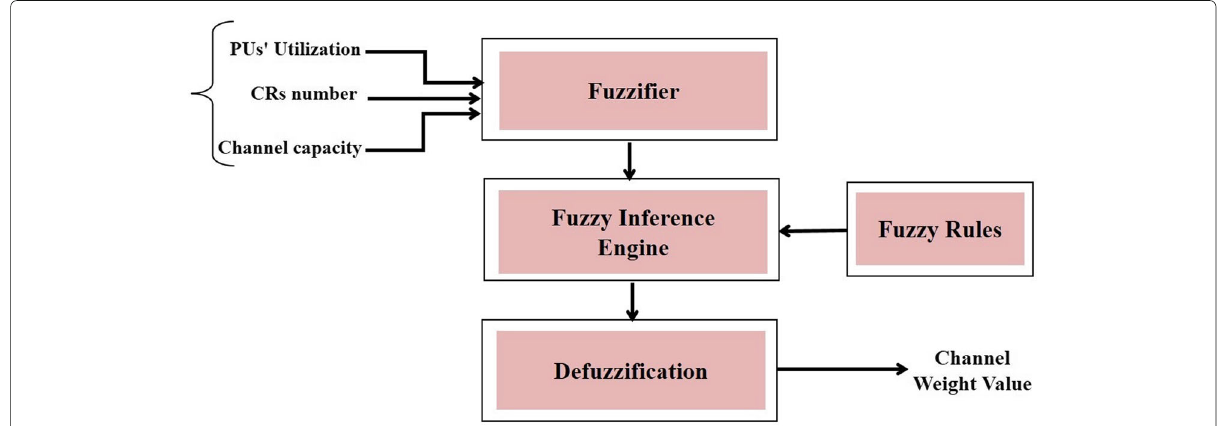
Fig. 3 Fuzzy inference system. The block diagram of the fuzzy inference system are shown